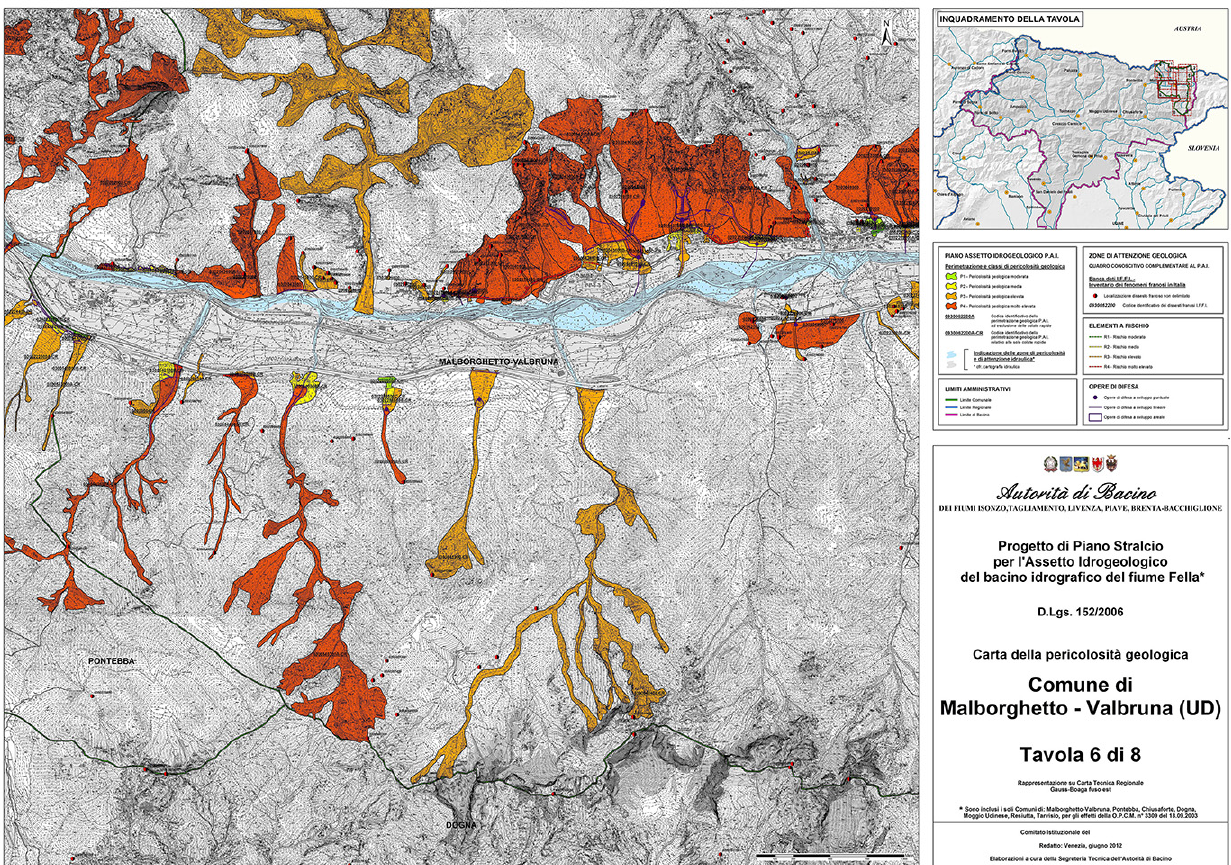
Figure 4. Geomorphological hazard map – PAI, commune of Malborghetto-Valbruna, Italy (Autorità di bacino dei fiumi dell’Alto Adriatico, 2012). The map comprises all types of mass movements: rapid flows, falls, topplings, surficial slides and rotational/translational slides. Red areas indicate a highly elevate geomorphological hazard, orange areas indicate high geomorphological hazard, yellow areas indicate medium geomorphological hazard, and violet lines and points indicate structural defense measures in